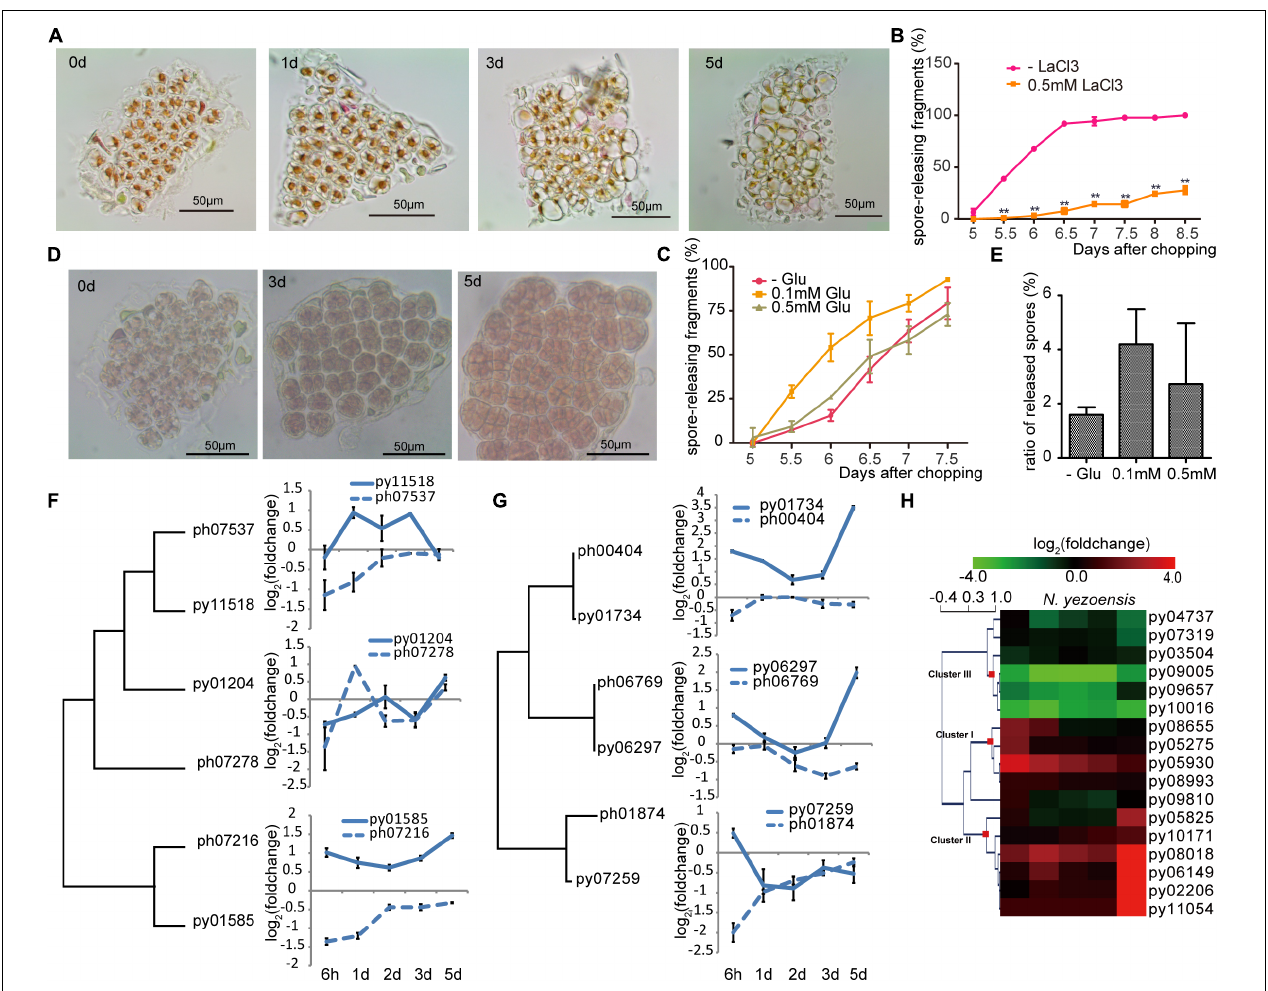
FIGURE 3 | Ca 2 + signaling in the wound-induced spore formation in N. yezoensis . (A) Effects of 1.0 mM LaCl 3 on boundary repair and sporangia formation, causing eventual cell death. Morphological changes in the same cut fragment tracked at 0, 1, 3, and 5 days after wounding. (B) Effect of 0.5 mM LaCl 3 on the percentage of cut fragments able to release spores. Average percentages of spore-releasing fragments plotted over time in control and LaCl 3 -treated media; error bars represent the SD ( n = 3, 30 fragments/replicate as described in “Materials and Methods” section). ** P < 0.01. (C) The percentage of cut fragments releasing spores with different dosages of L-glutamate. The plot follows the description for (B) . (D) Morphological changes in a cut fragment treated with 0.1 mM L-glutamate. (E) Effect of 0.1 mM of L-glutamate on spore release. Columns represent the ratio of released spores to original cells in corresponding fragment with the SD shown ( n = 3, 30 fragments/replicate). (F) Transcriptional variation of N. yezoensis GLR genes and their N. haitanensis counterparts. The dendrogram was constructed by maximum-likelihood and plots for each gene were done as described in Figure 2C . (G) Transcriptional variation of N. yezoensis calmodulin genes and their N. haitanensis counterparts. The dendrogram and plots are as described in (F) . (H) Heatmap showing the transcriptional variation of CDPK genes in N. yezoensis and N. haitanensis . The log 2 value of FPKM foldchange compared to the intact sample at each time point (see “Materials and Methods” section) for individual genes are displayed, as indicated by the color bar. The three clusters of CDPK genes discussed in the text were generated by Hierarchical Clustering and are indicated by red squares on the